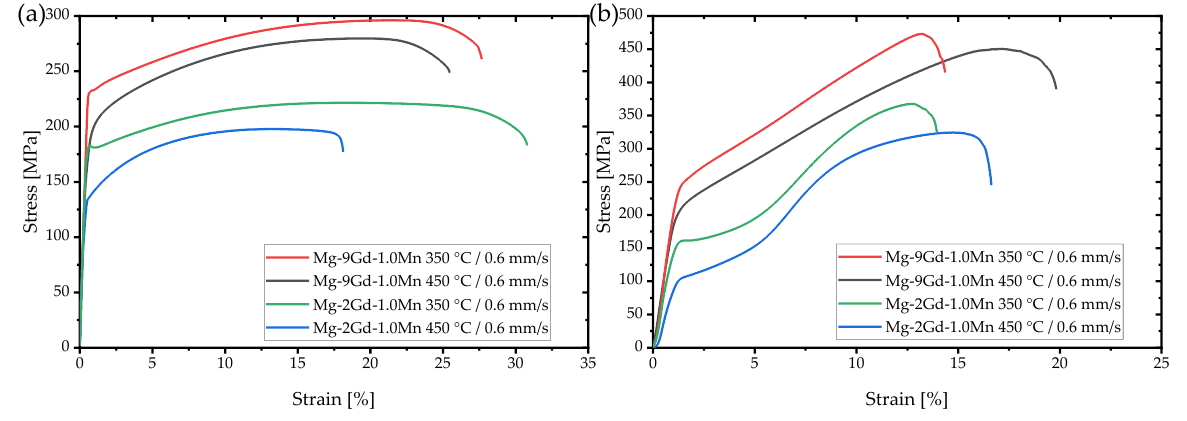
Figure 7. Examples of the stress – strain-curves from ( a ) tensile and ( b ) compression test. Table 2. Mechanical properties with respect to extrusion parameters and